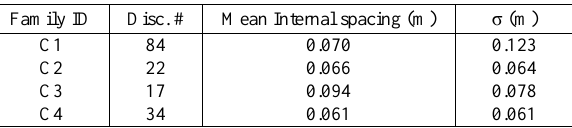
Table 11. Results for the internal characterization of the corridor of F2